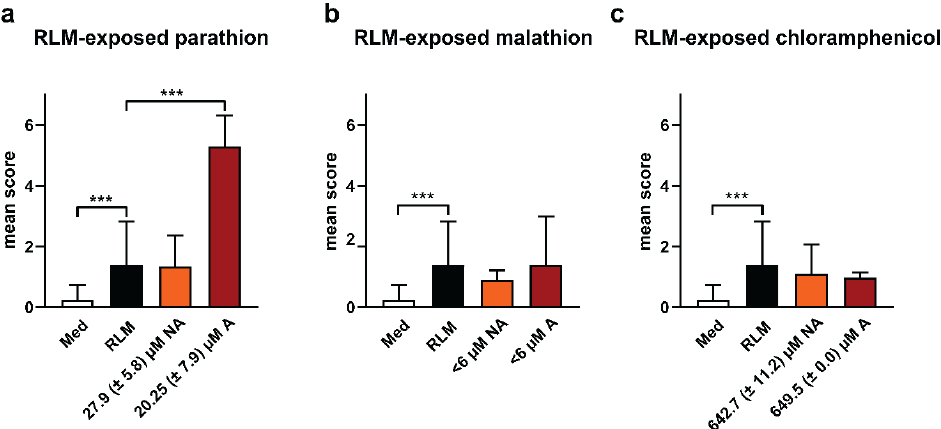
Figure 2. Mean scores of lethality and sub-lethal toxicity of test compounds ( a ) parathion, ( b ) malathion, and ( c ) chloramphenicol previously exposed to RLM activated (A) or not (NA) with reduced β-nicotinamide adenine dinucleotide 2′-phosphate (NADPH) and glucose-6-phosphate (G6P) in zebrafish eleuthero embryos. The bar charts show the results after incubation of three dpf zebrafish eleuthero embryos with 4-fold dilutions of reconstituted extracts of processed samples that were analyzed on their content (see Figure 3). Control conditions consisted out of eleuthero embryos exposed to the RLM extract (without compound spiking) in the medium (indicated as RLM), and eleuthero embryos exposed to the medium without the RLM extract and without spiking (indicated as Med). After 48 h the incubated eleuthero embryos were morphologically screened, and the mean scores calculated, as described in methods. Three independent experiments were performed, the data were pooled and the mean ± SD was calculated. Hence, a total of 30 eleuthero embryos were processed per condition. For the statistical analysis, the mean score of RLM was compared with the mean scores of the other samples by using one-way ANOVA with Dunnett’s multiple comparison test. *** p ≤ 0.001.